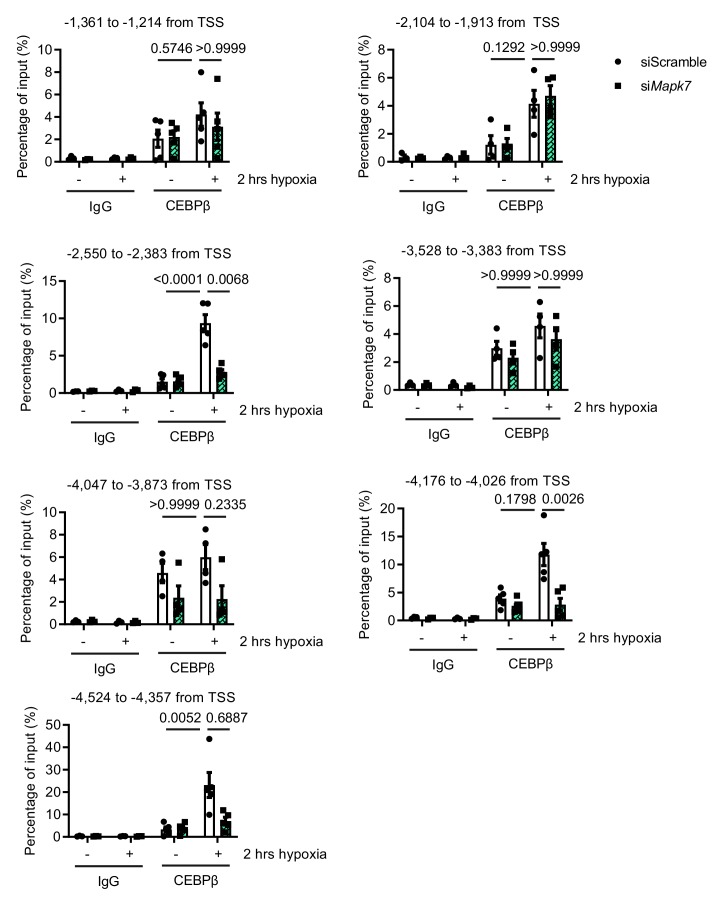
CEBPβ binding analysis to Pri-mir128-1 intronic promoter.Chromatin immunoprecipitation (ChIP) assay was performed on ARCMs DNA using anti-CEBPβ antibody (anti-IgG antibody as the negative control). The enrichment of CEBPβ binding to different regions in Pri-mir128-1 intronic promoter localized between exon1 and exon2 of R3hdm1 was examined by qPCR in the presence and absence of Mapk7 in response to hypoxia. TSS: transcription start site. Data were normalized to input chromatin (N = 3–5 experiments). Data presented as mean ± SEM. Two-way ANOVA followed by Bonferroni post hoc tests was employed to compare groups.Figure 3—figure supplement 5—source data 1.CEBPβ binding analysis to Pri-mir128-1 intronic promoter.